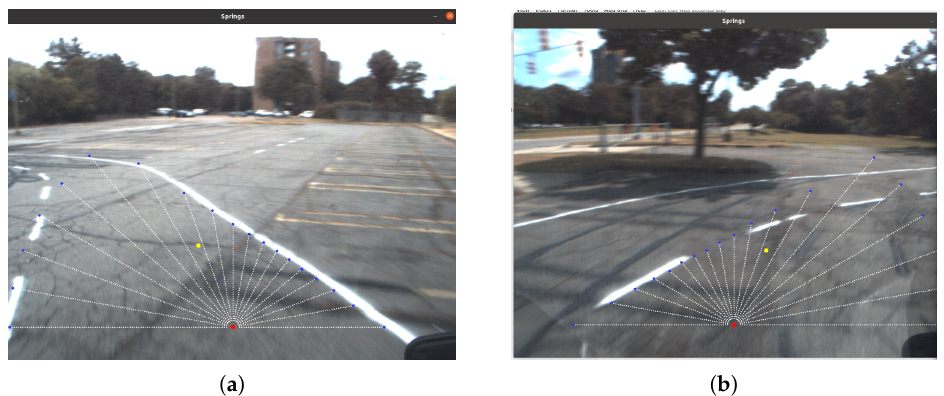
Figure 19. Visual Representation of the Hough Lines and the center point. The rays are drawn out to meet the Hough lines. The inner lane image shows how the algorithm works even on a sharp turn.